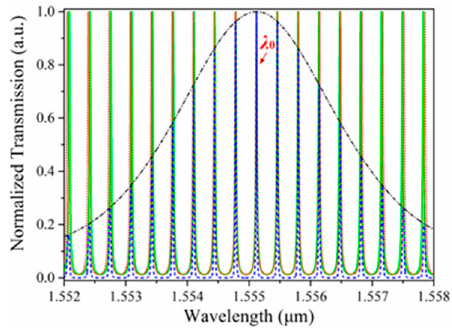
Figure 3. Transmission spectra of the individual sensing resonator, the reference resonator, and the cascaded resonators.